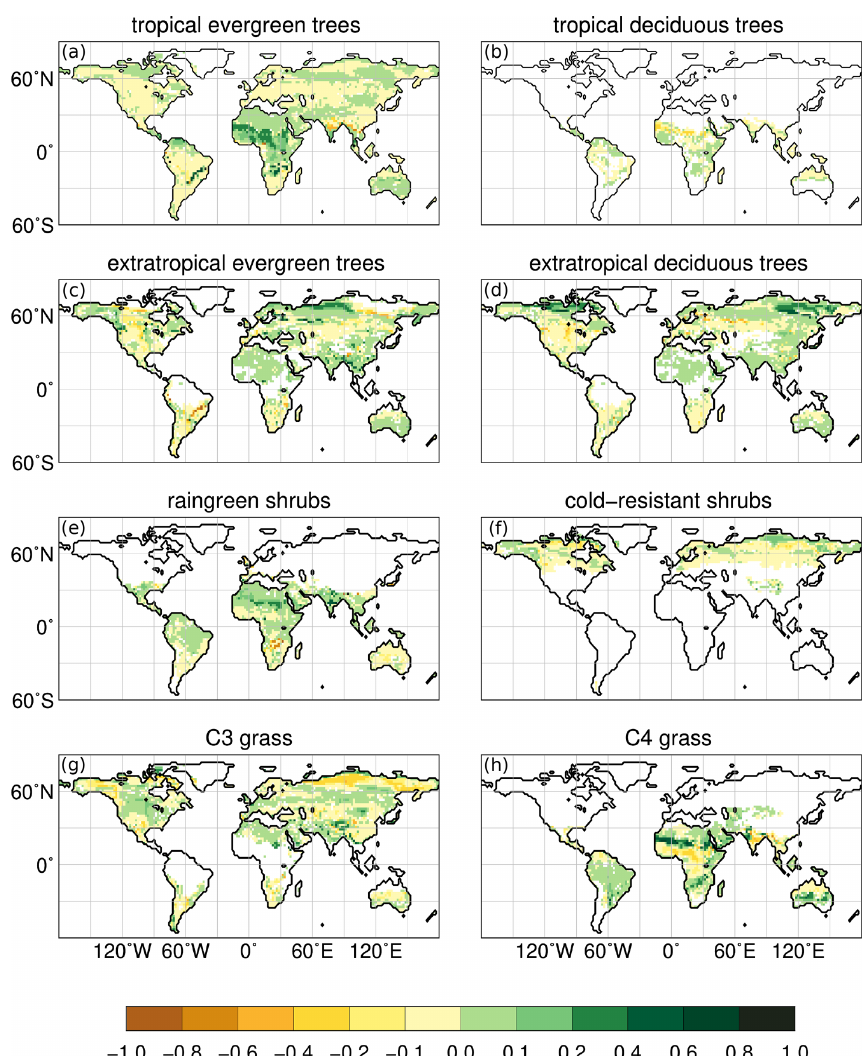
Figure 7. Simulated changes in PFTs for the early mid-Holocene time slice (at 8ka) compared to the late Holocene (2.15ka); i.e. the yellowish colour indicates a decreased in PFT cover fraction at 8ka, greenish colour an increased PFT cover fraction at 8ka compared to 2.15ka. Values of “1.0” mean that the grid box is fully covered by the PFT during 8ka, but does not occur at 2.15ka in this grid cell, and vice versa for values of “ − 1.0”. Only significant changes are shown ( t test, 99% confidence